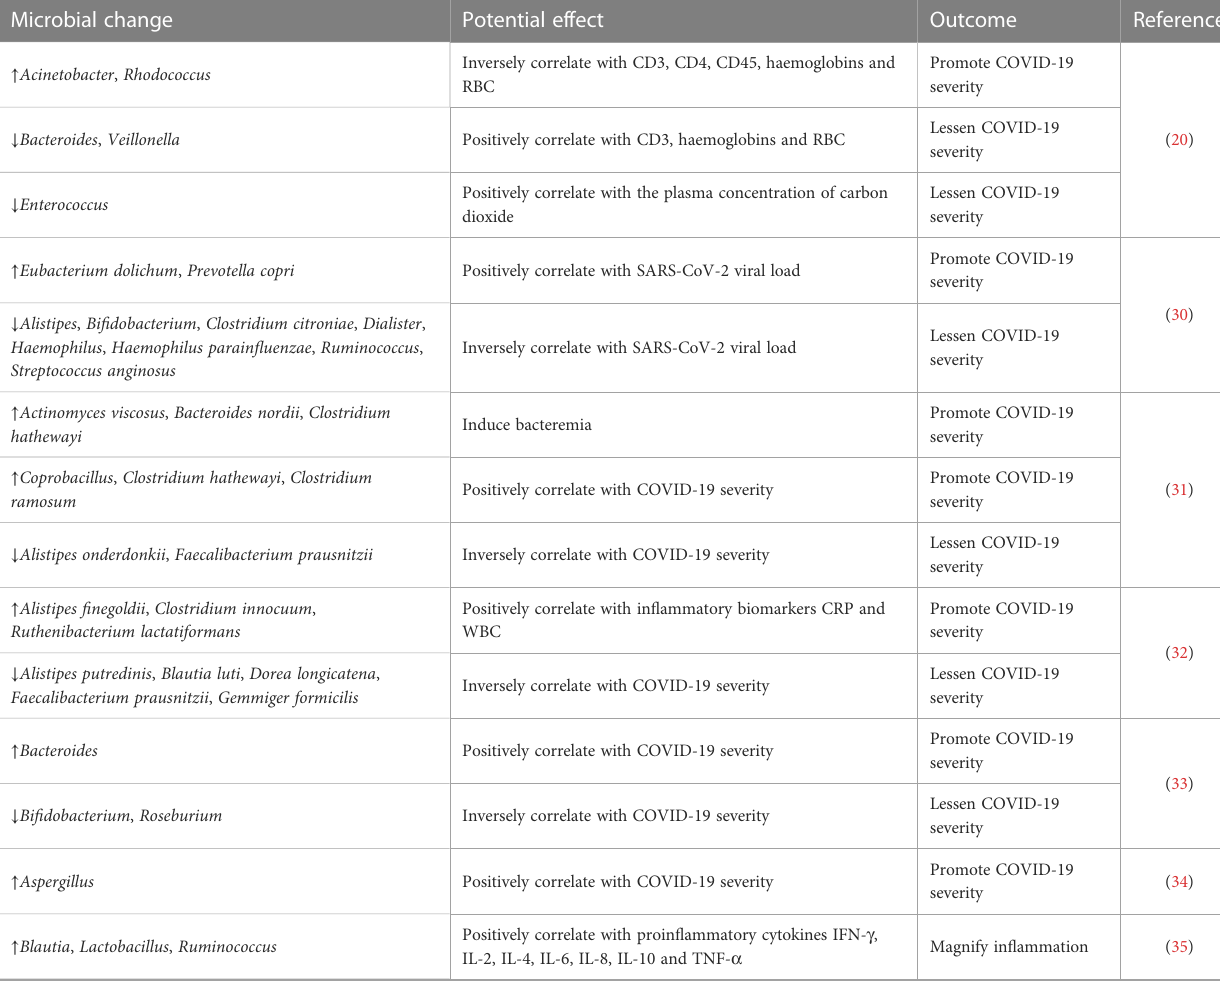
TABLE 2 Effects of dysregulated gut microbiota on the immune status and COVID-19 progression. Microbial